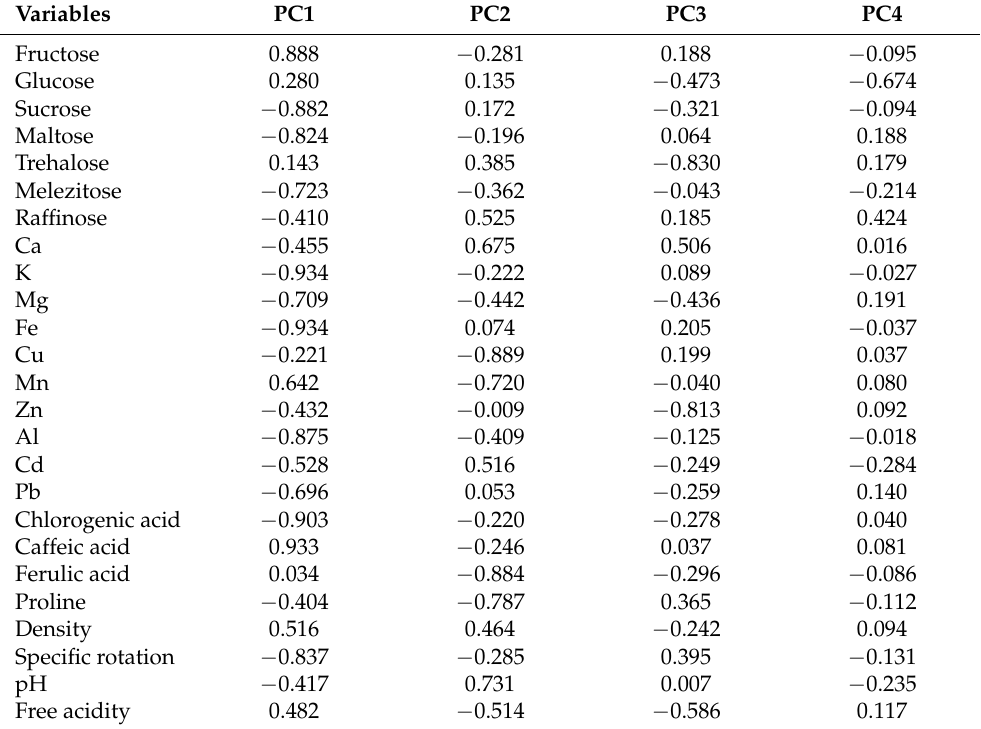
Table 3. Loadings of the variables for the four principal